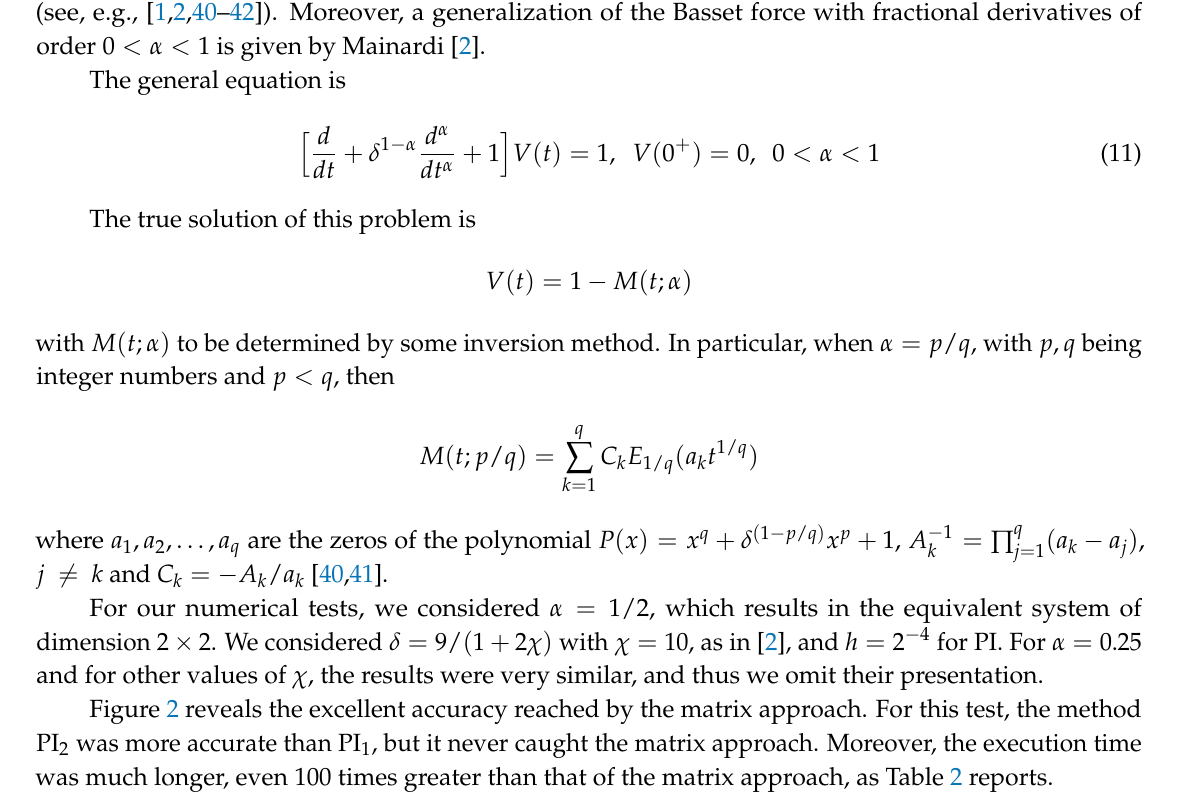
Table 2. Comparison of execution time for the matrix approach and the product integration (PI) methods for computing the approximate solution at T for α =